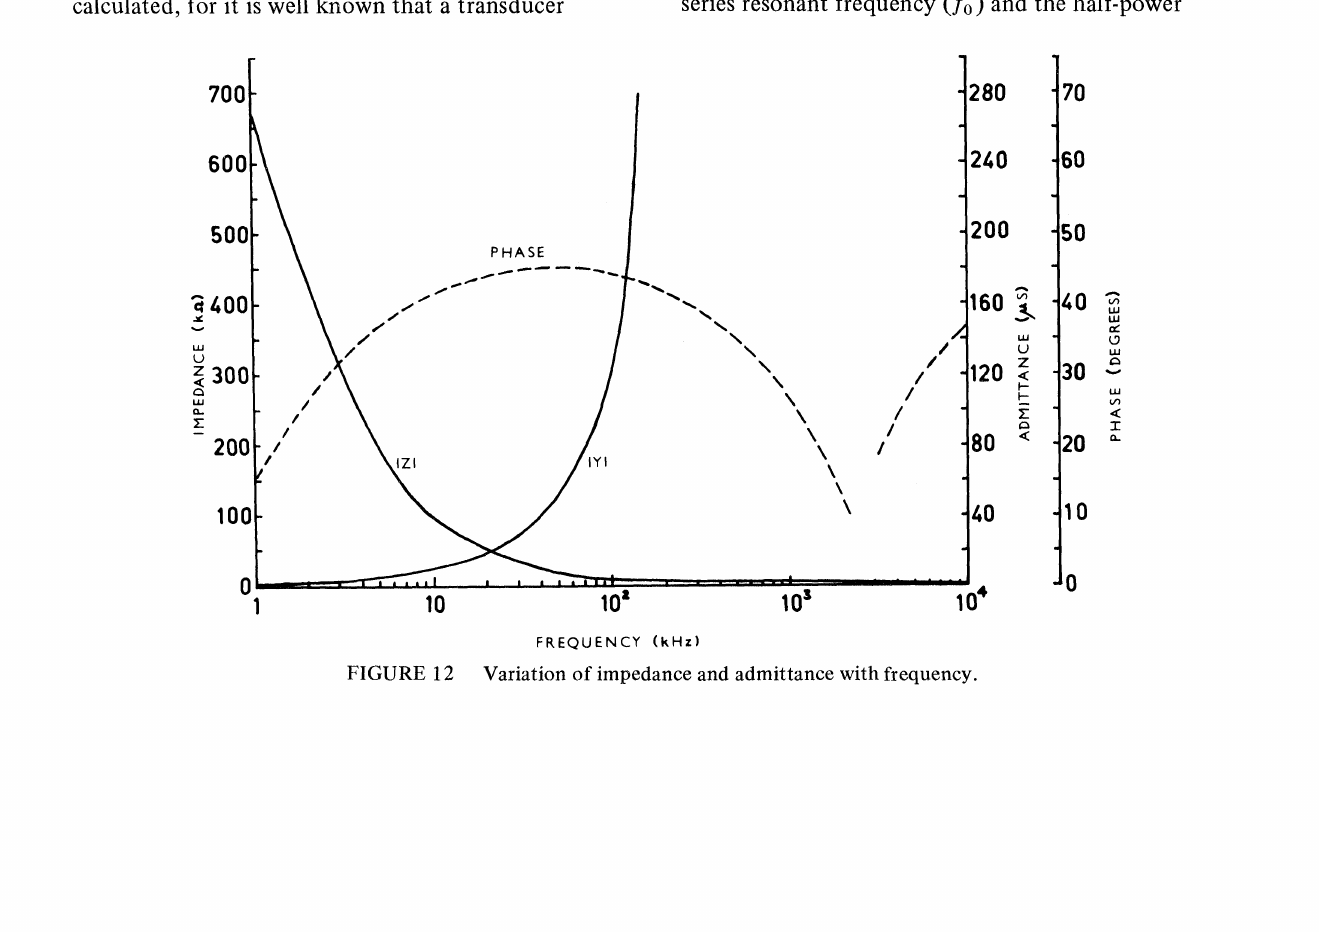
Oscilloscope traces of electrical pulse applied to a PZT-4 projector (upper trace) and corres- ponding transmitted acoustic pulse as detected by a PVDF hydrophone (projector voltage 24 V, hydrophone voltage 400/.tV, time axis grid 50/as per division). driven by a constant amplitude oscillating voltage takes Q/rr cycles to reach 0.4 and Q cycles to reach 0.9 of its steady state energy dissipation. Similarly, it takes Q cycles to ring down to 0.1 of its steady state amplitude. Thus, an approximation of the transducer’s Q can be obtained directly from a time- expanded oscilloscope trace of the pulse received by a PVDF hydrophone. This method gave a Q of 33. An exact value of Q can be obtained from. the series resonant frequency (fo) and the half-power